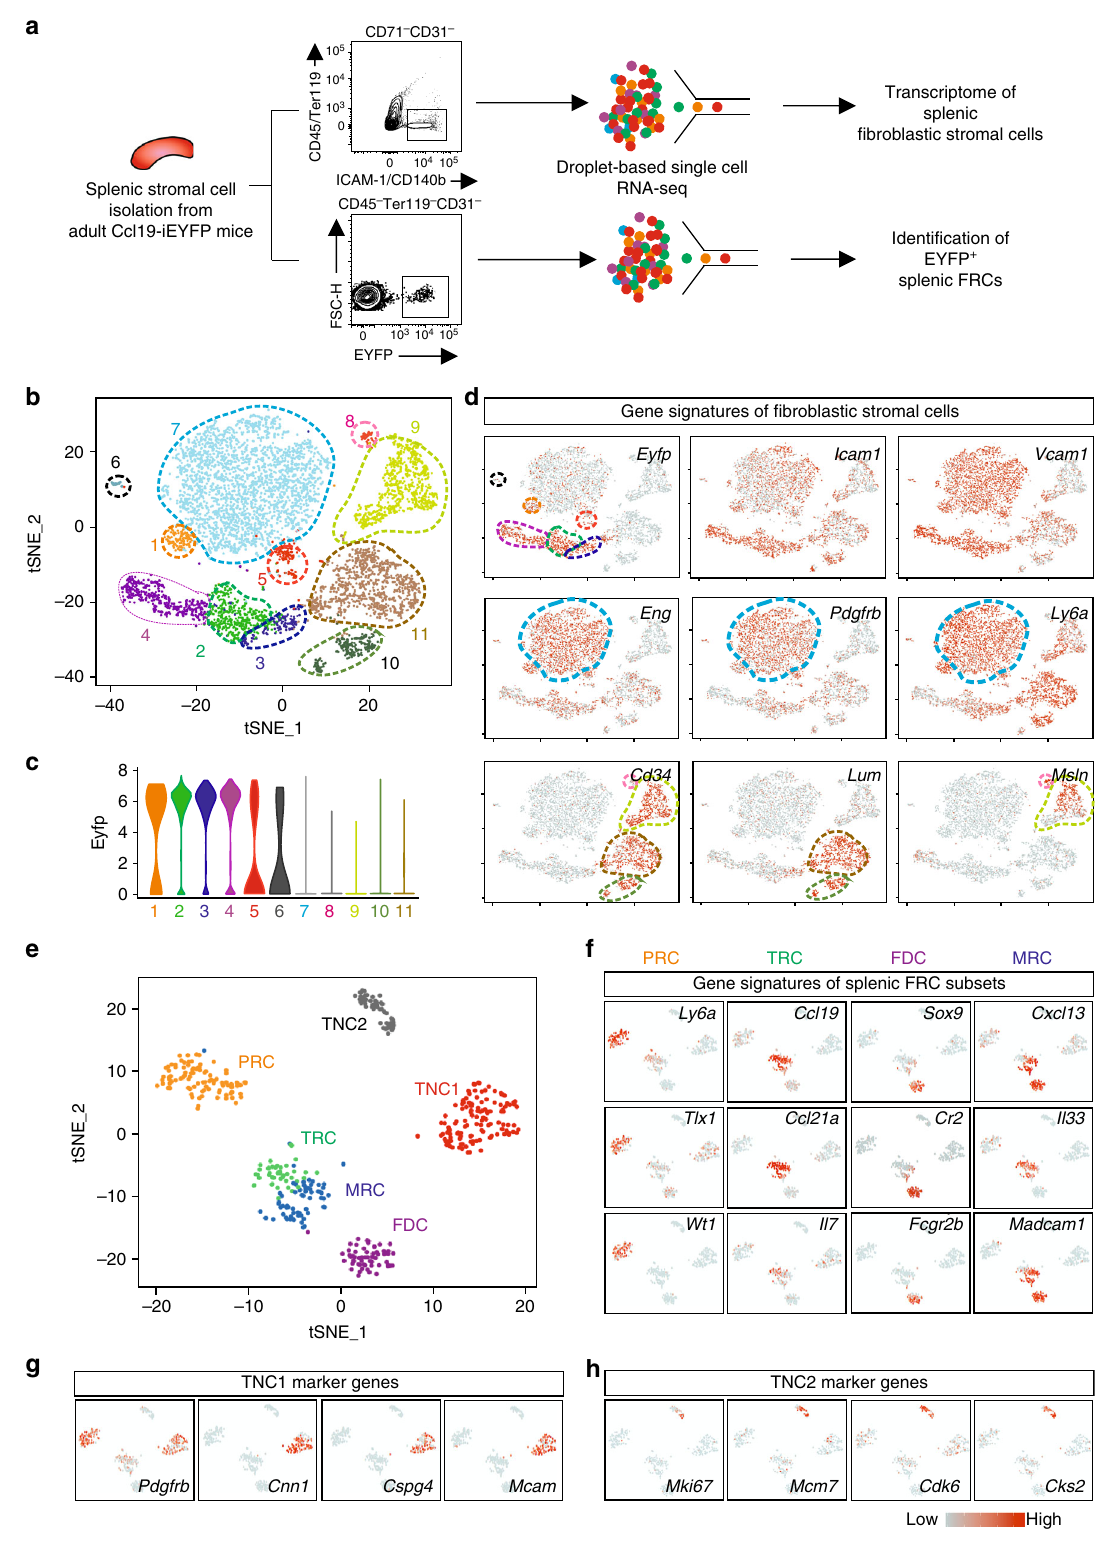
Fig. 5 Transcriptomic analysis of splenic white pulp reticular cells. a Schematic depiction of the droplet-based scRNA-seq work fl ow. b tSNE map of sorted splenic fi broblastic stromal cells from adult Ccl19-iEYFP mice. c Violin plots of Eyfp expression in different clusters based on the scRNA-seq analysis. d Gene signatures of distinct splenic reticular cell subsets. The density of the red color represents the expression level of the genes. e tSNE map of sorted EYFP + cells from adult Ccl19-iEYFP mice demarcated with the reticular cell populations. scRNA-seq data are pooled from two independent experiments. f – h Gene signatures of distinct splenic reticular cell subsets acquired from scRNA-seq analysis. The density of the red color represents the expression level of the